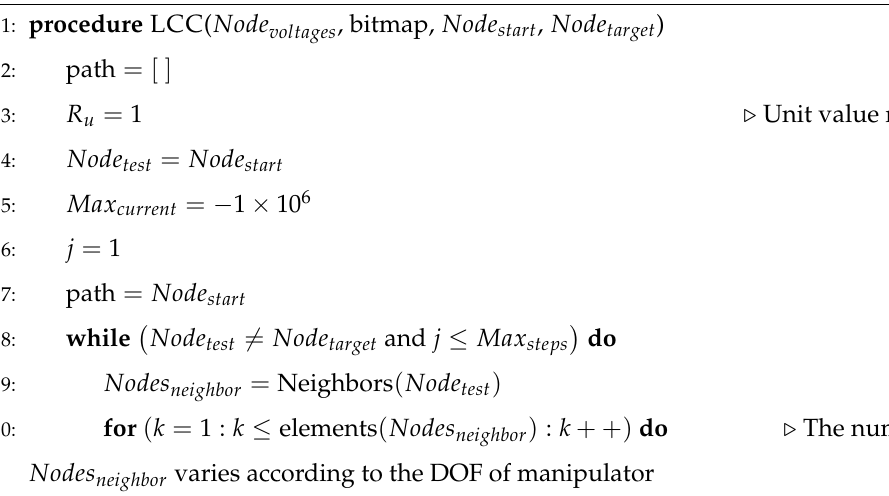
Algorithm 3 Calculation of the solution path using